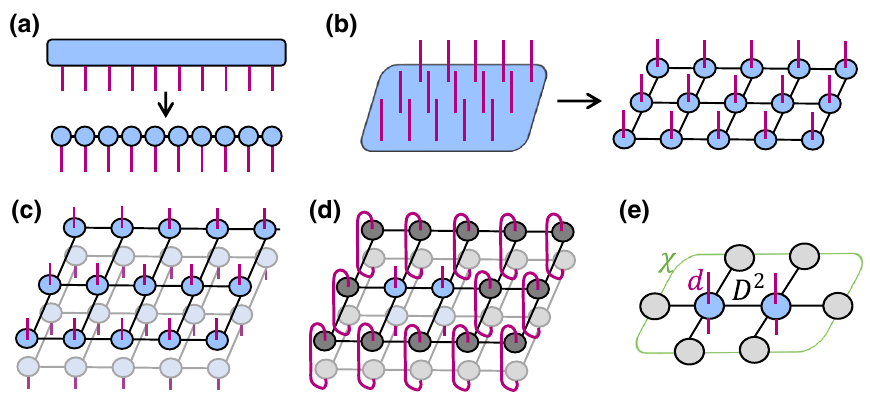
FIG. 1. (a),(b) A general pure quantum state can be thought of as a rank- N tensor represented by a single tensor with N legs (indices), each with degree d . The full tensor capturing the entire quantum state can be decomposed into N tensors, each representing a single site. The legs of the original tensor (in pink) are now divided between all tensors, and will be referred to as the physical index. Each tensor has additional legs connecting it to its neighbors, which will be referred to as the bond index. Contracting all the bond indices will result in the original tensor. Panels (a) and (b) represent states in one and two spatial dimensions, respectively. Panel (c) represents the density matrix of a pure state by taking two copies and applying complex conjugation to one of them, which is indicated by the physical index facing downwards. (d) The RDM of the sites in blue is obtained by tracing out the degrees of freedom of the sites in gray, which in turn is obtained by contracting the physical legs of both copies. (e) The RDM can be represented by the site tensors of the sites in A from both copies, which is here represented by a single tensor with two physical legs, and boundary tensors, which have only bond indices. In order to obtain the boundary tensors, we use the boundary MPS method [68]. The dimension of the bond indices in black is D 2 , while that of the legs in green, connecting the boundary tensors to each other, is χ , the bond dimension of the